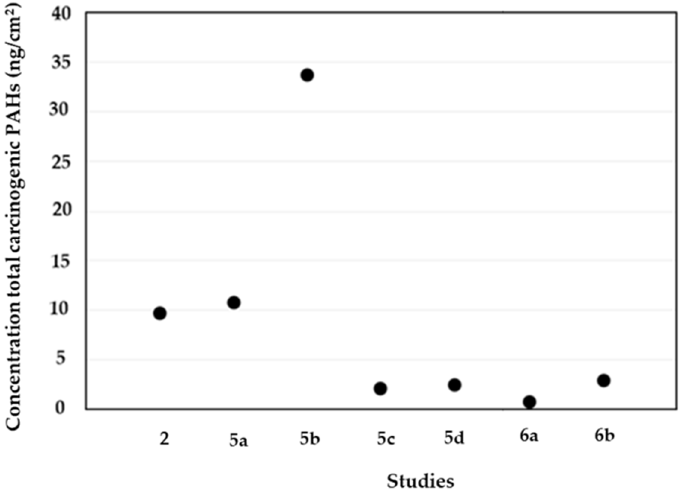
Figure 3. Concentrations of total carcinogenic PAHs (benzo(a)pyrene, naphthalene, benz(a)anthracene, chrysene, benzo(b)fluoranthene, benzo(j)fluoranthene, benzo(k)fluoranthene, benzo(e)pyrene, indeno(1,2,3-c,d)pyrene and dibenzo(a.h)anthracene) on the skin of firefighters after firefighting activities (2—Fernando et al. [45] (neck, wrist, back, forehead, and fingers);